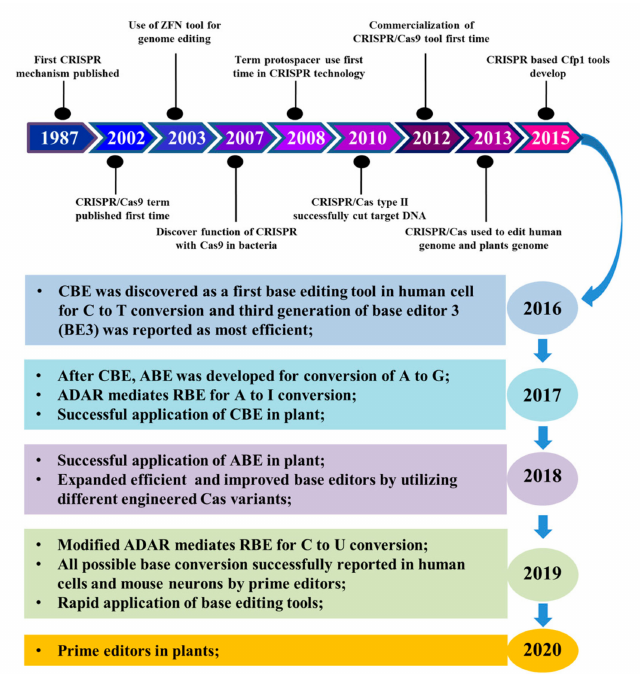
Figure 1. Progress of genome editing. Milestones of genome editing tools and brief history of base editing. ZFN, zinc-finger nucleases; CBE, cytosine base editor; ABE, adenine base editor;